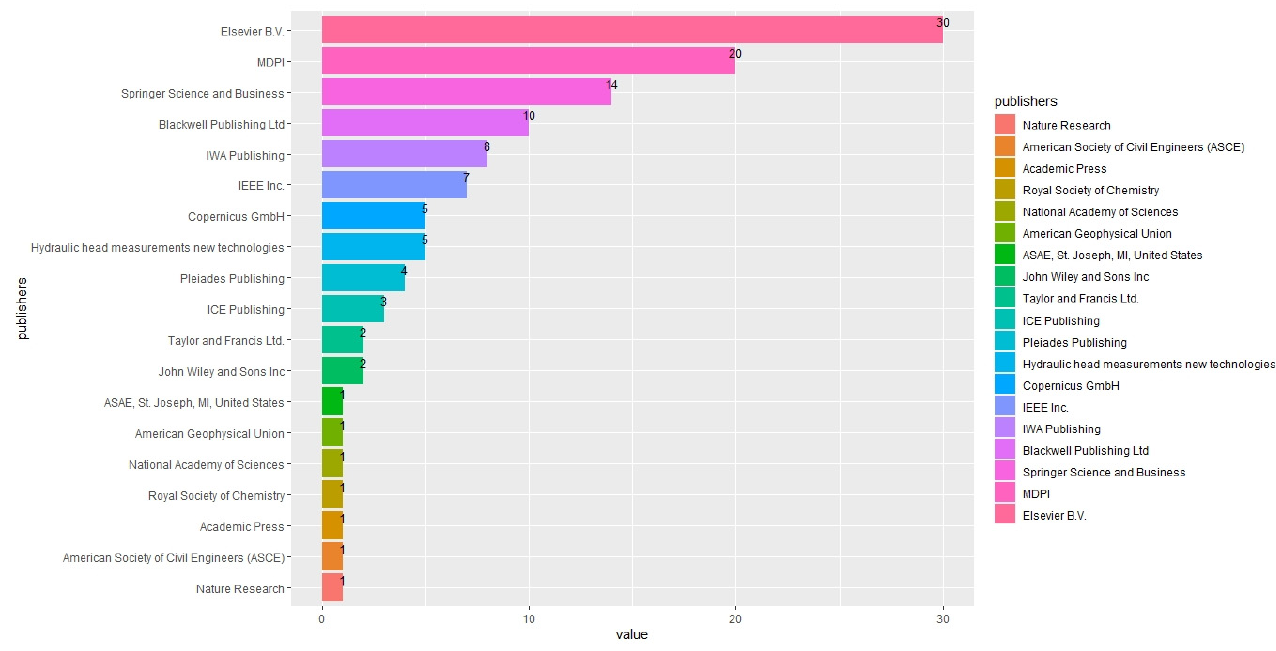
Figure 5. Publication outlets from the primary studies.